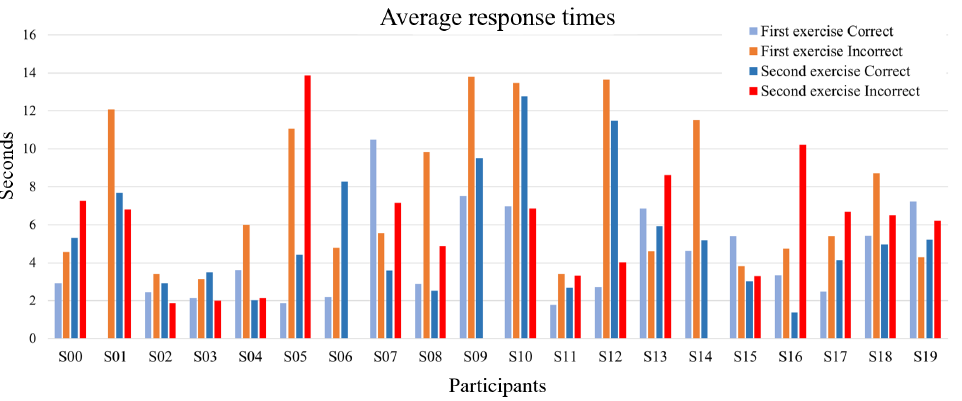
Figure 7. Average response times. Average response time per subject classified as correct and incorrect, in the first and second approaches (after an incorrect